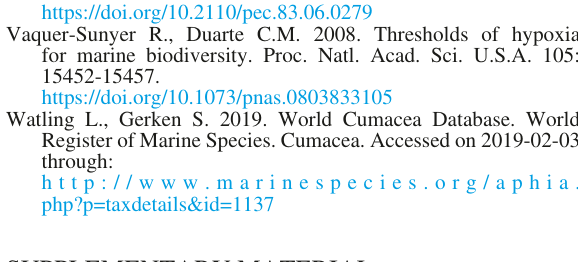
Table S1. – Vertical distribution of cumacean individuals in the near-bottom water layers (N1, 10-40 cm; N2, 45-75 cm;